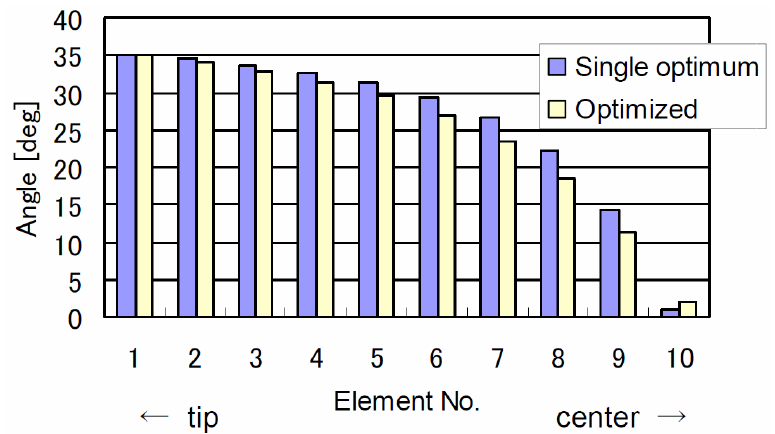
Fig. 15 Comparison between the optimized angle and single optimum